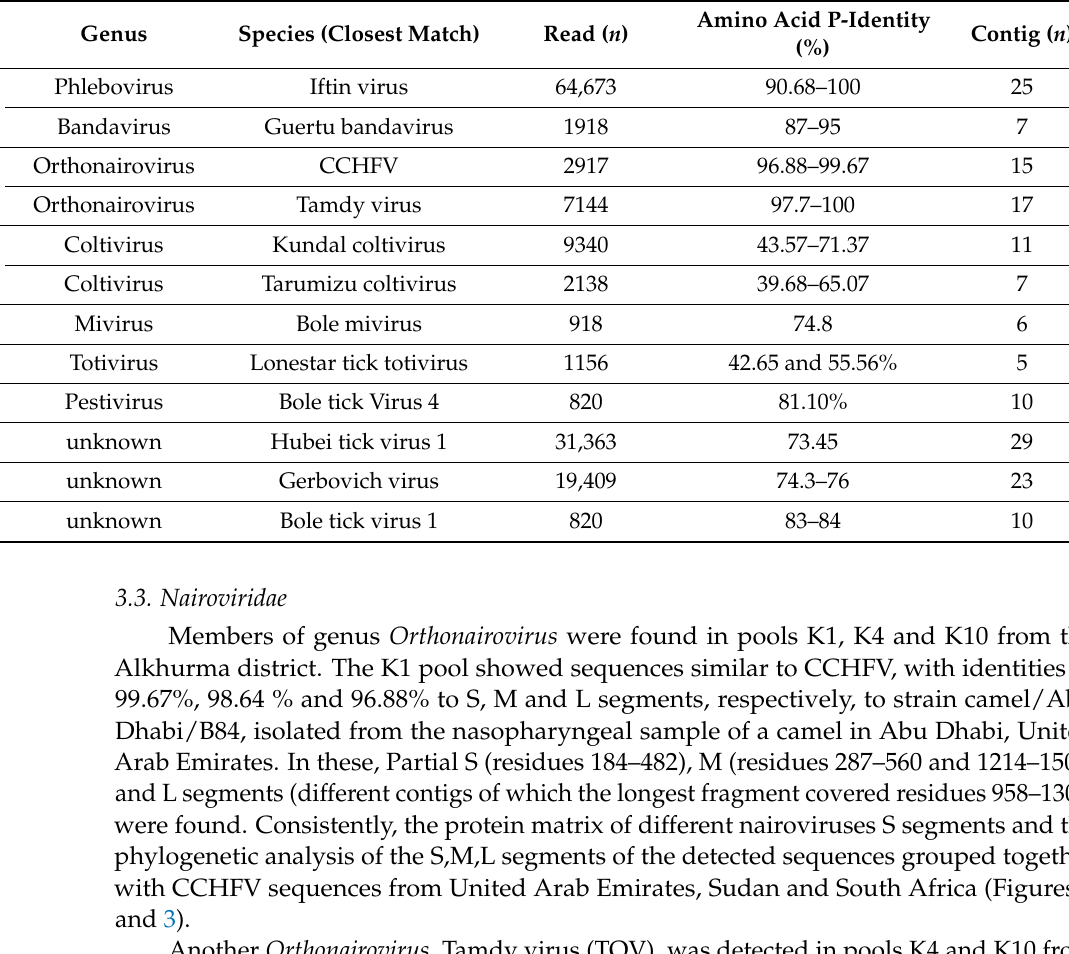
Table 1. Summary of virus families, genera, species number of reads, percentage of identity (amino acids) and number of contigs